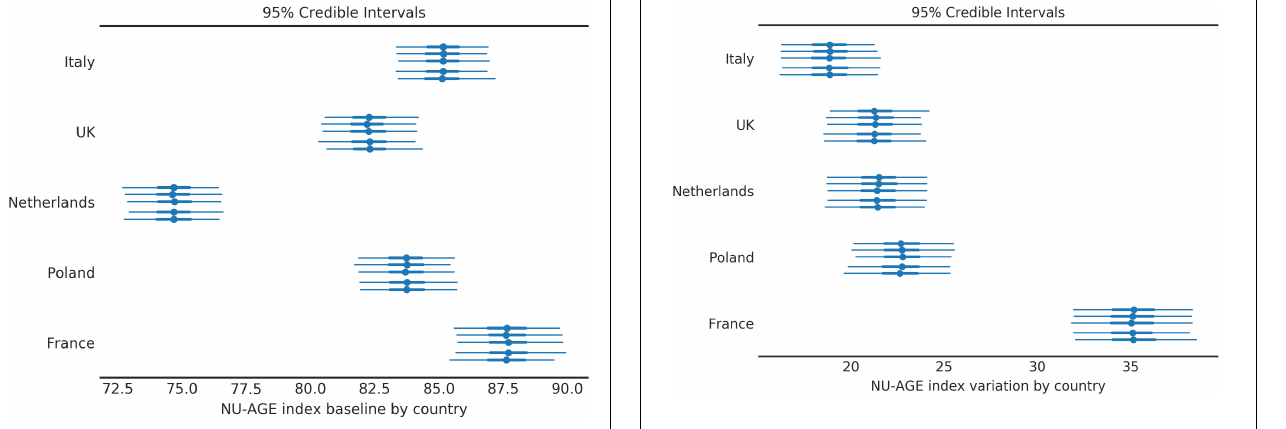
FIGURE 3 | Baseline NU-AGE index for the population by country. Each country is divided in 5 segments to assess the variability among simulations (each simulation corresponds to one line). The central point represents the mean of the posterior distribution, the thick line represents the 50% HDI, the thin line represents the 95% HDI.